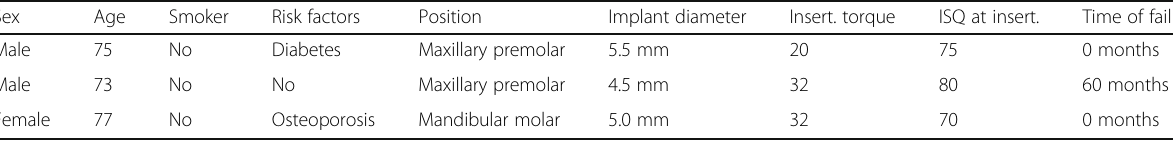
Table 3 Specification of failed implants (three implants in three